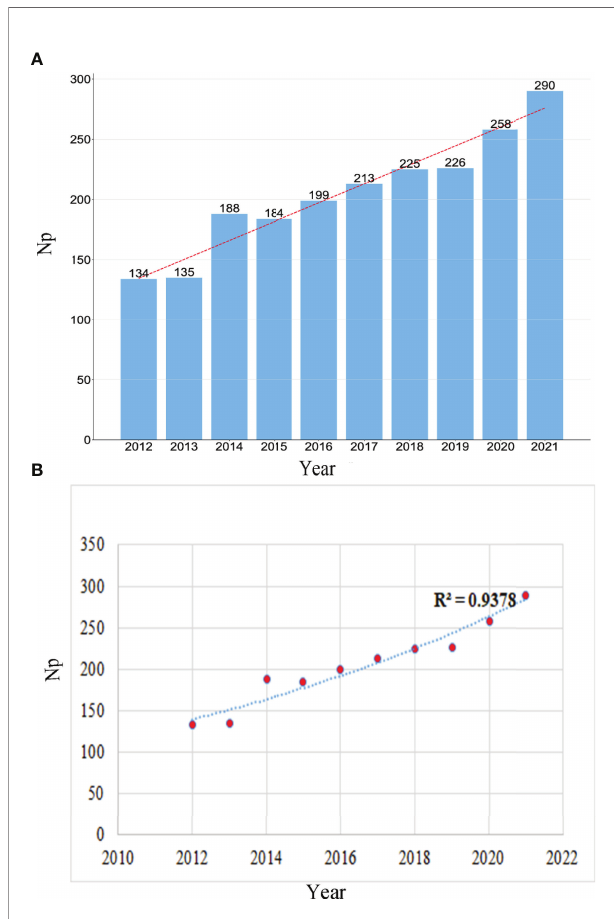
FIGURE 3 | (A) The number of publications by year during the last ten years. (B) Curve fi tting of publications ’ overall yearly growth trend.